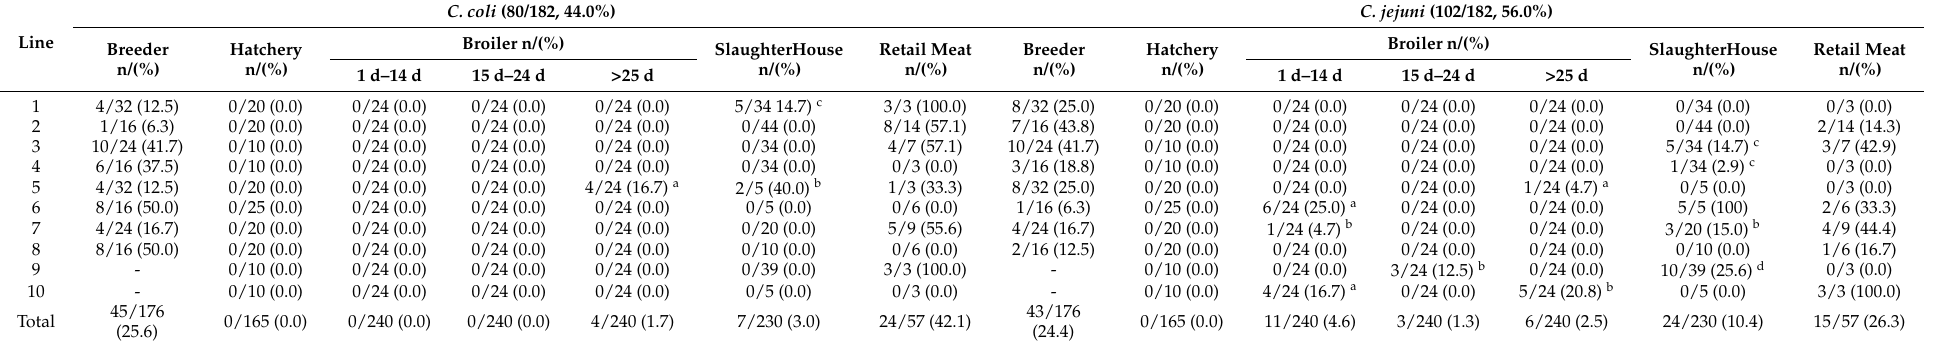
Table 1. Distribution of Campylobacter coli and C. jejuni isolated from different lines along the chicken production chain.